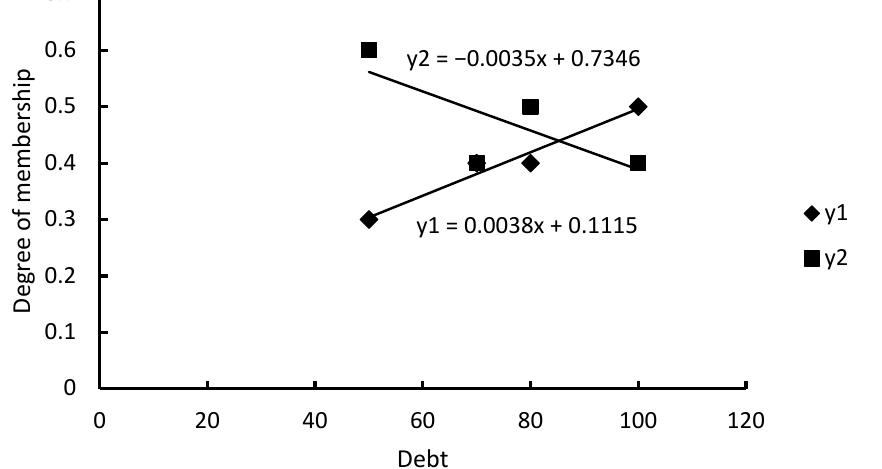
Figure A15. Single factor evaluation for the index of debt (50–100 (inclusive) ten thousand yuan).